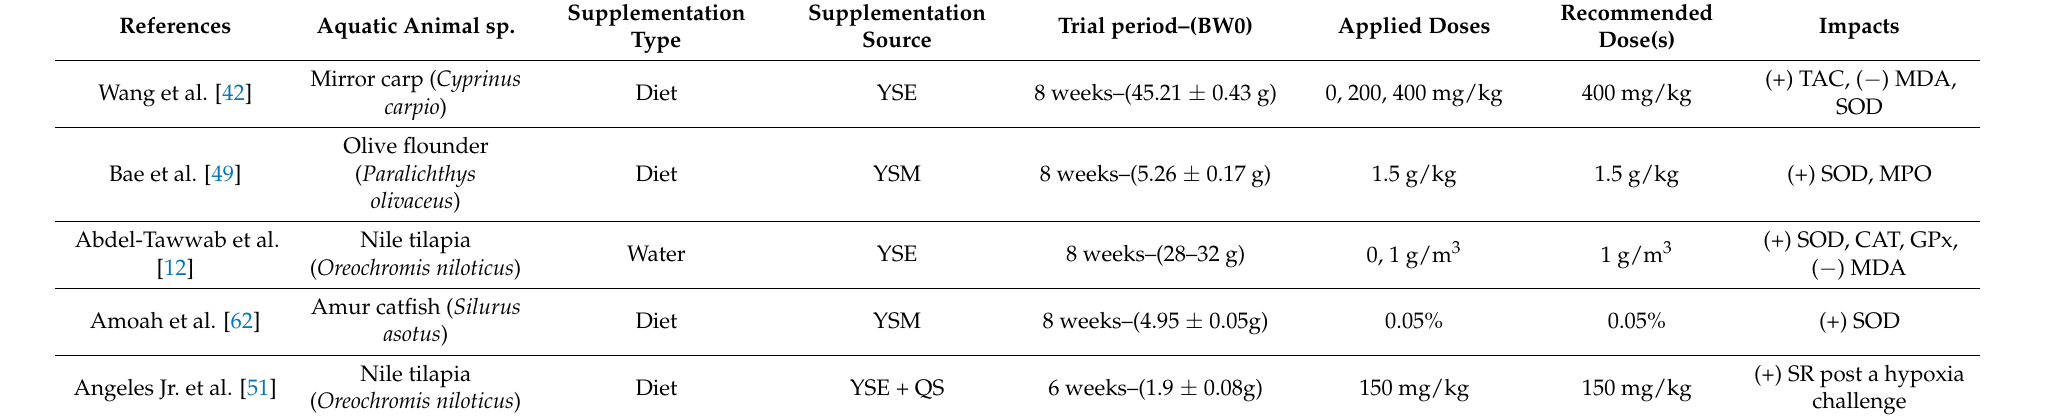
Table 3. Yucca schidigera ’s impacts on the antioxidants of aquatic